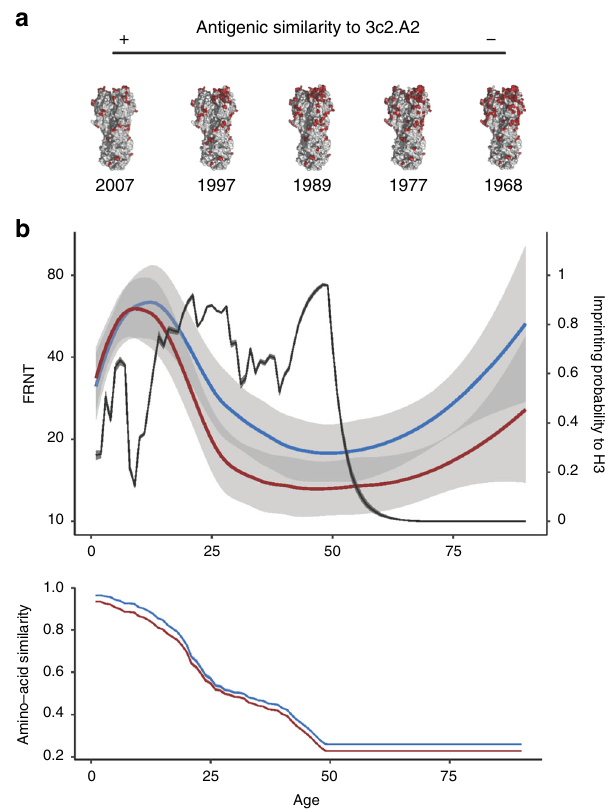
Fig. 4 Early life H3N2 imprinting affects antibodies against 3c2.A viruses. a H3 has evolved substantially since 1968 and residue differences between the HA of different H3N2 strains and the 3c2.A2 strain are indicated in red. Accession numbers EF409245 (1968), CY113261 (1977), U97740 (1989), AJ311466 (1997), and EU199250 (2007) were aligned to accession number MH586372 (3c2.A2). b Top, mean FRNT titers to 3c2.A (blue line) and 3c2.A2 (red line) viruses are shown by Loess curves (span = 0.6) with the 95% CIs shaded. The probability that an individual was imprinted with H3N2 (i.e., their fi rst in fl uenza A virus encounter was H3N2) is indicated with a black line. Bottom, the antigenic similarity between the HA of an individual ’ s imprinting H3N2 strain and 3c2.A (blue line) and 3c2. A2 (red